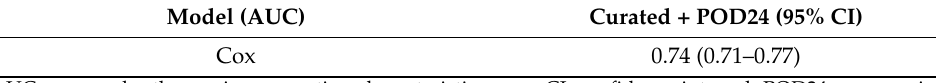
Table 3. Cox model performance with curated set and